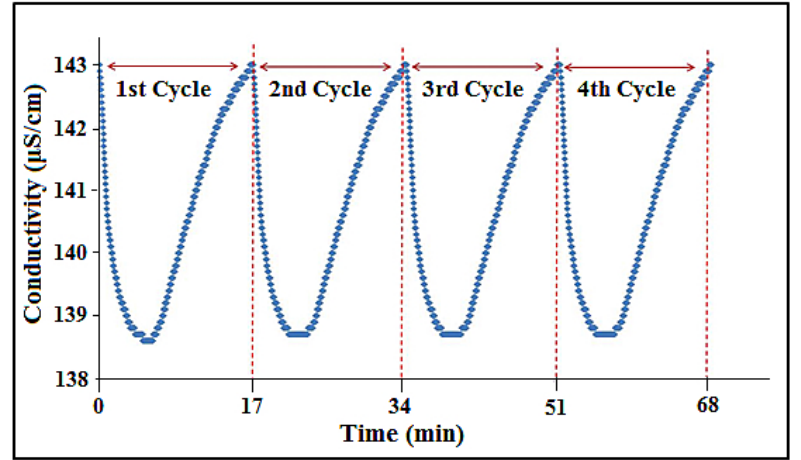
Figure 10. Multiple electrosorption–desorption cycles of 75 ppm NaCl solution for the 23.58 wt% a-SWCNT-coated RVC electrode. Polarization and depolarization were performed at 1.5 V and 0.0 V,